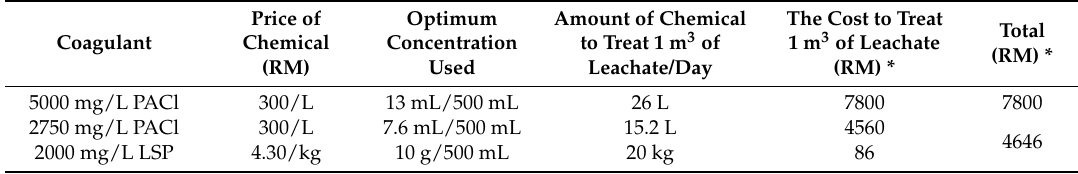
Table 2. Cost estimation for PACl and LSP.